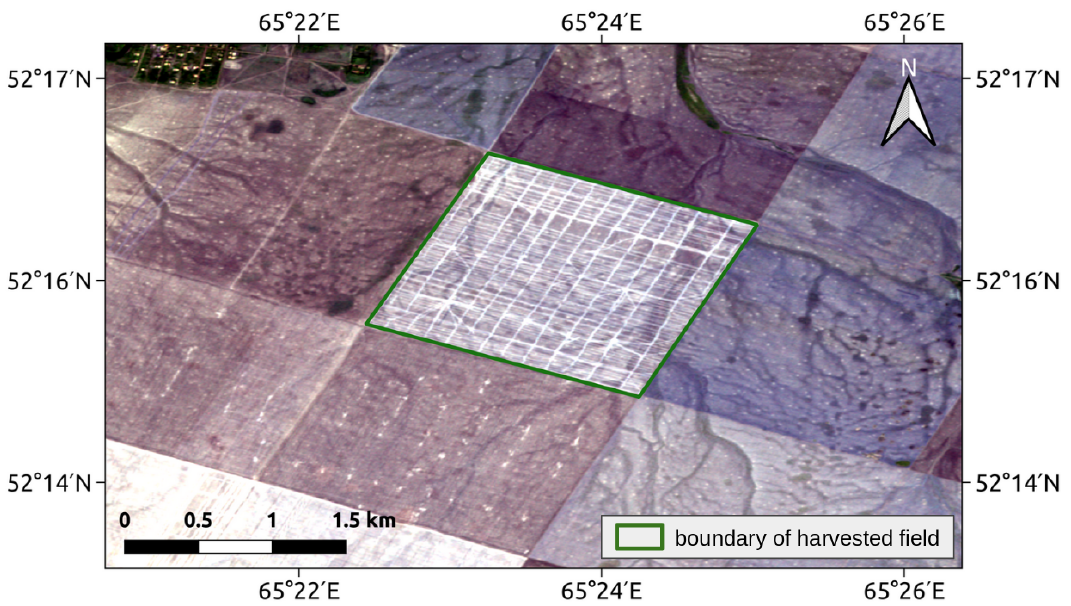
Figure 3. Example of a harvested field (Sentinel-2 satellite